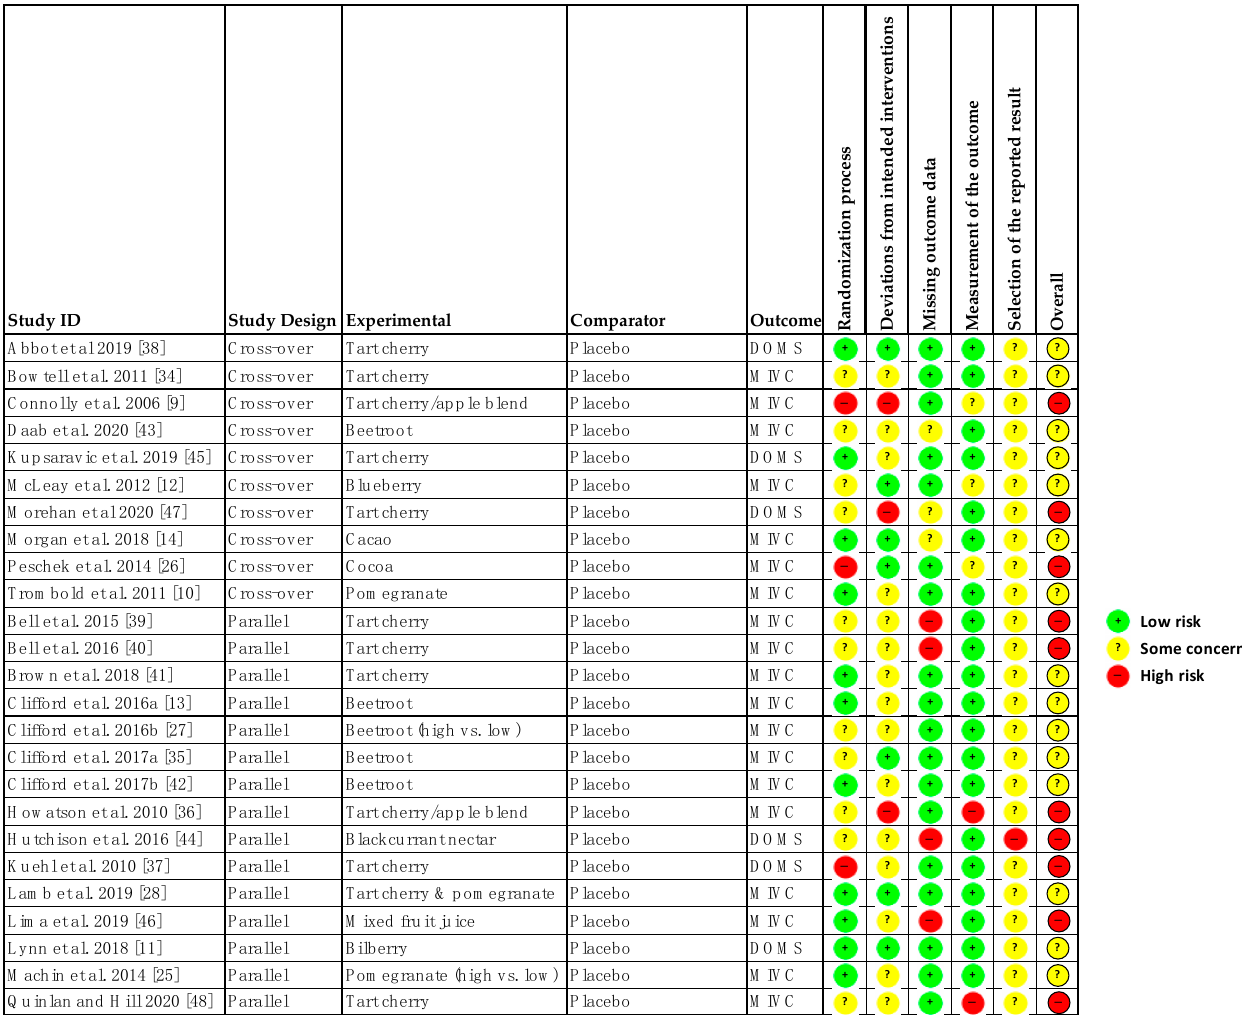
Pom egranate (high vs. low ) Placebo